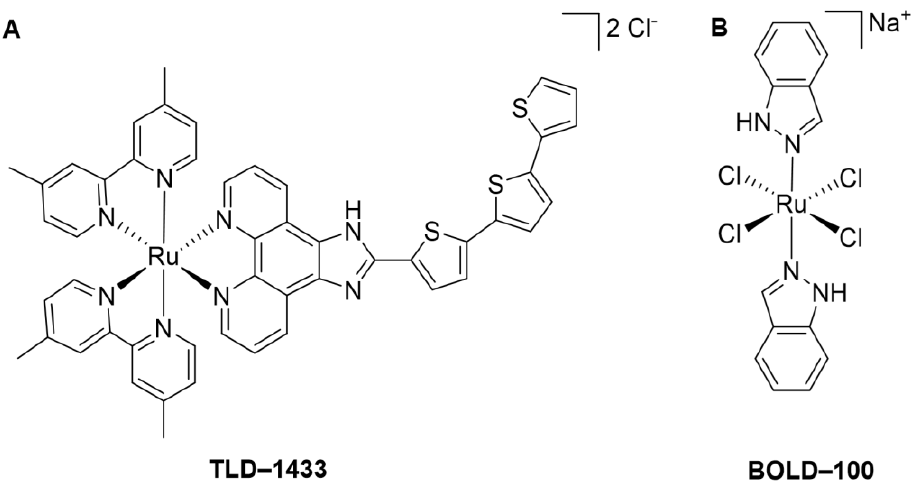
Figure 1. Chemical structures of clinically studied ruthenium compounds. Ru(II) coordination compound TLD – 1433 ( A ) and Ru(III) drug BOLD – 100 ( B ).